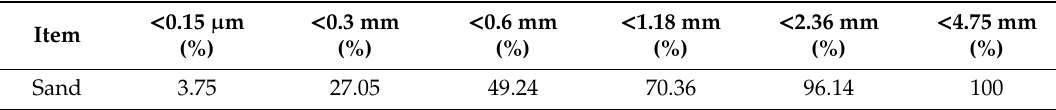
Table 2. Particle size distribution of